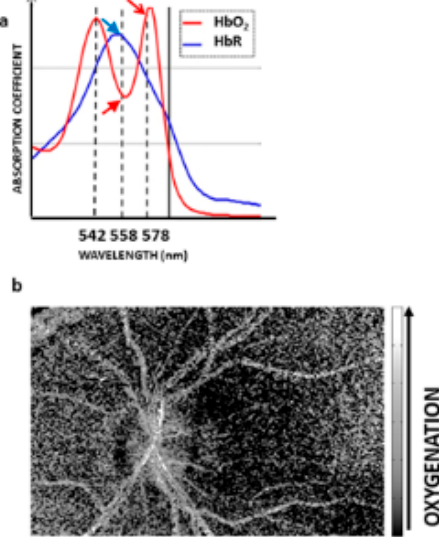
Figure 5. Visualisation of a two-wavelength ratio of reflectance spectra: ( a ) absorbance spectra of HbO 2 and HbR showing three selected wavelengths, 558 nm with a peak of HbR (blue arrow) and a trough of HbO 2 (red short arrow) and the dual peak of HbO 2 at 542 and 578 nm (red arrow), ( b ) grayscale image of the ratios of reflectance at 558 and 578 nm. Regions in white correspond to areas of high relative oxygenation.